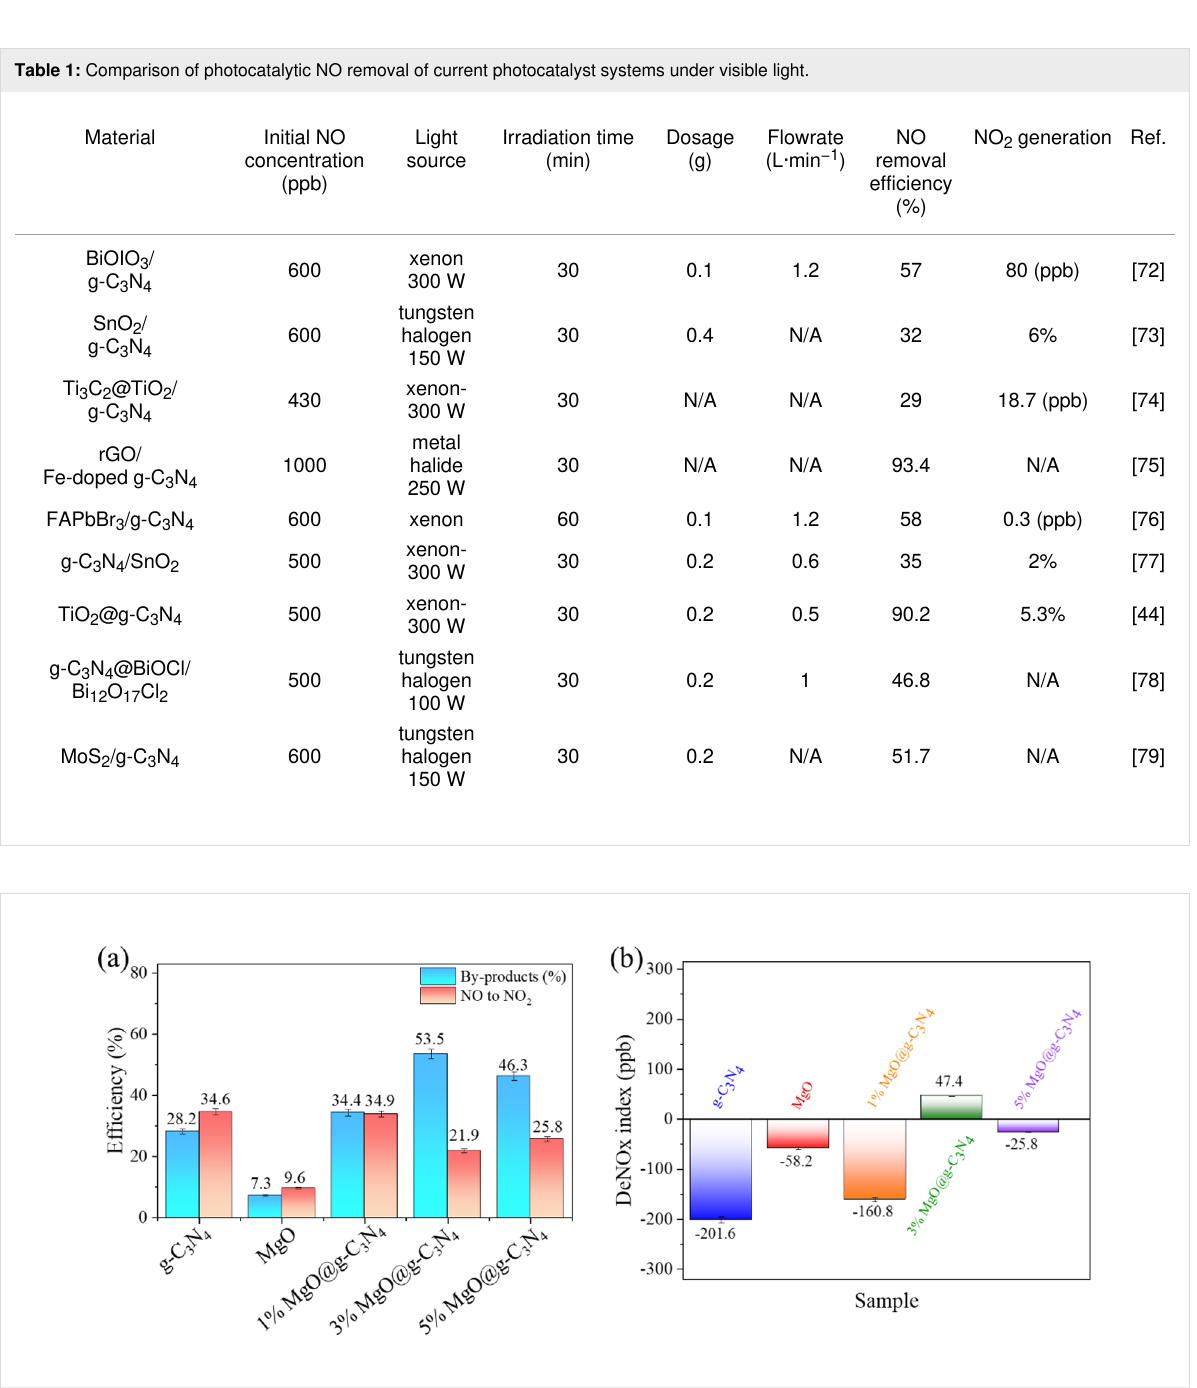
by-product (53.5%) generation. In addition, the NO 2 generation of g-C 3 N 4 is almost equal to that of 1% MgO@g-C 3 N 4 . This can be explained by the low amount of MgO (only 1%).